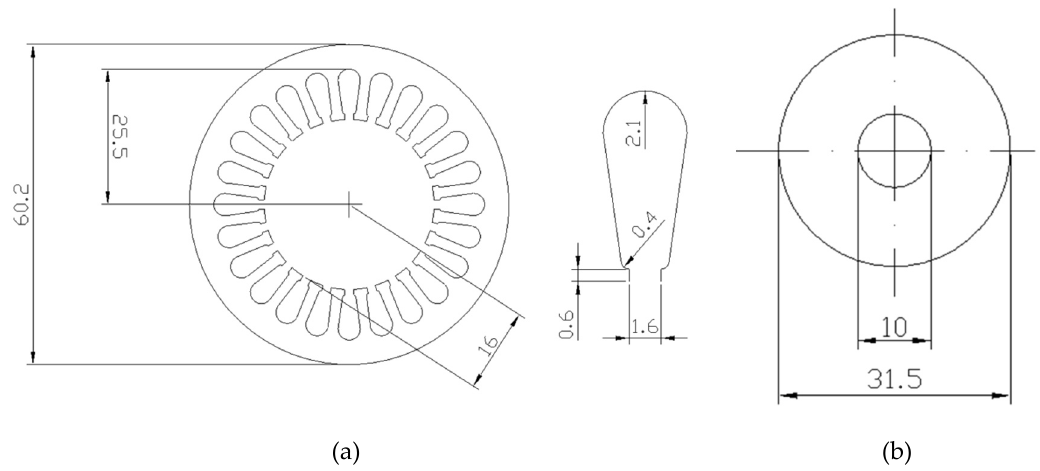
Figure 1. Solid-rotor induction machine taken into consideration: ( a ) dimensions of the stator package (cross section area), ( b ) dimensions of the rotor.